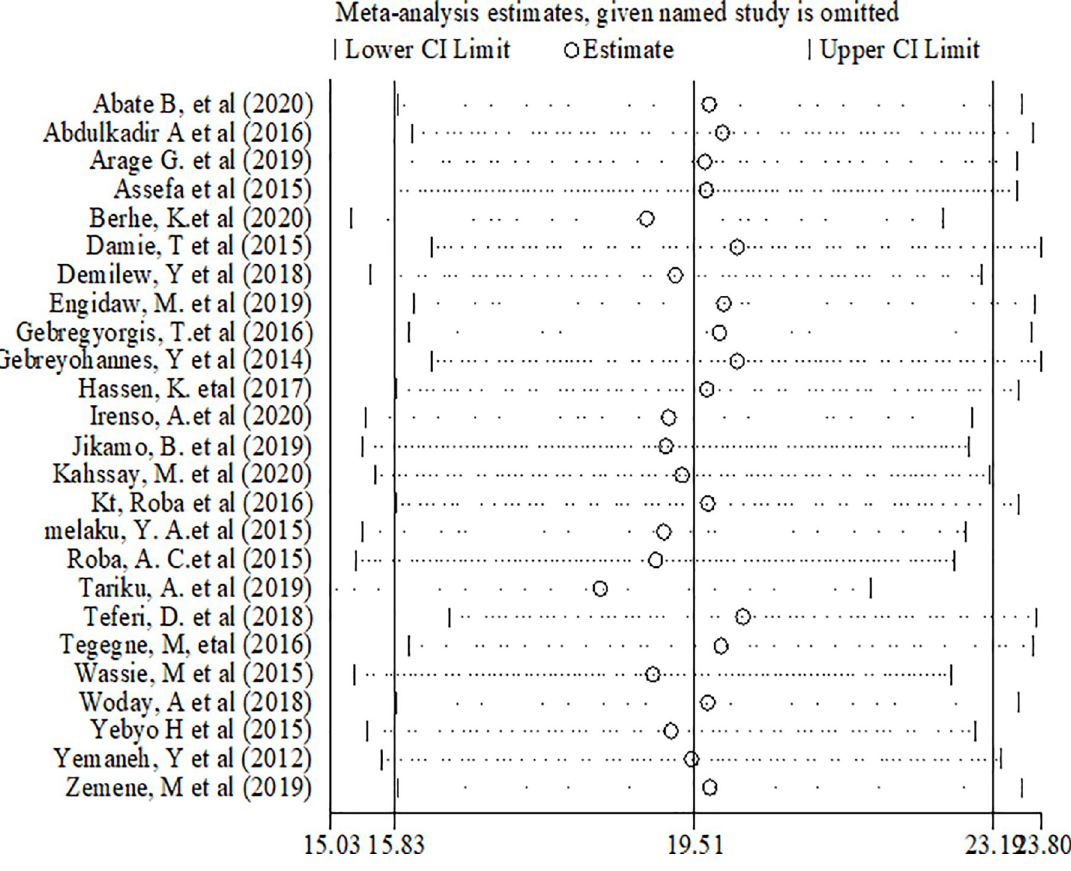
Fig 5. Sensitivity analysis of stunting among adolescents in